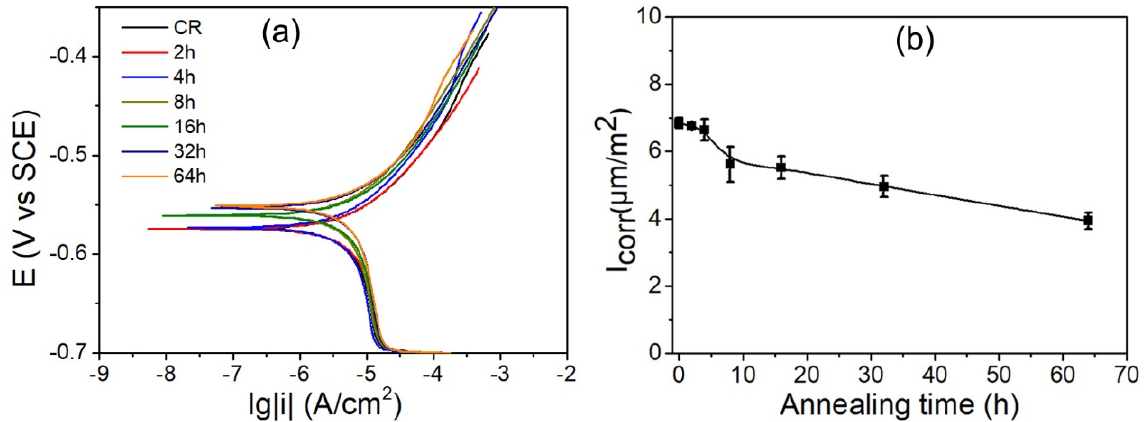
Figure 6. Potentiodynamic polarization curves ( a ) and calculated corrosion current density, I corr , ( b ) of various annealed IF steel specimens.